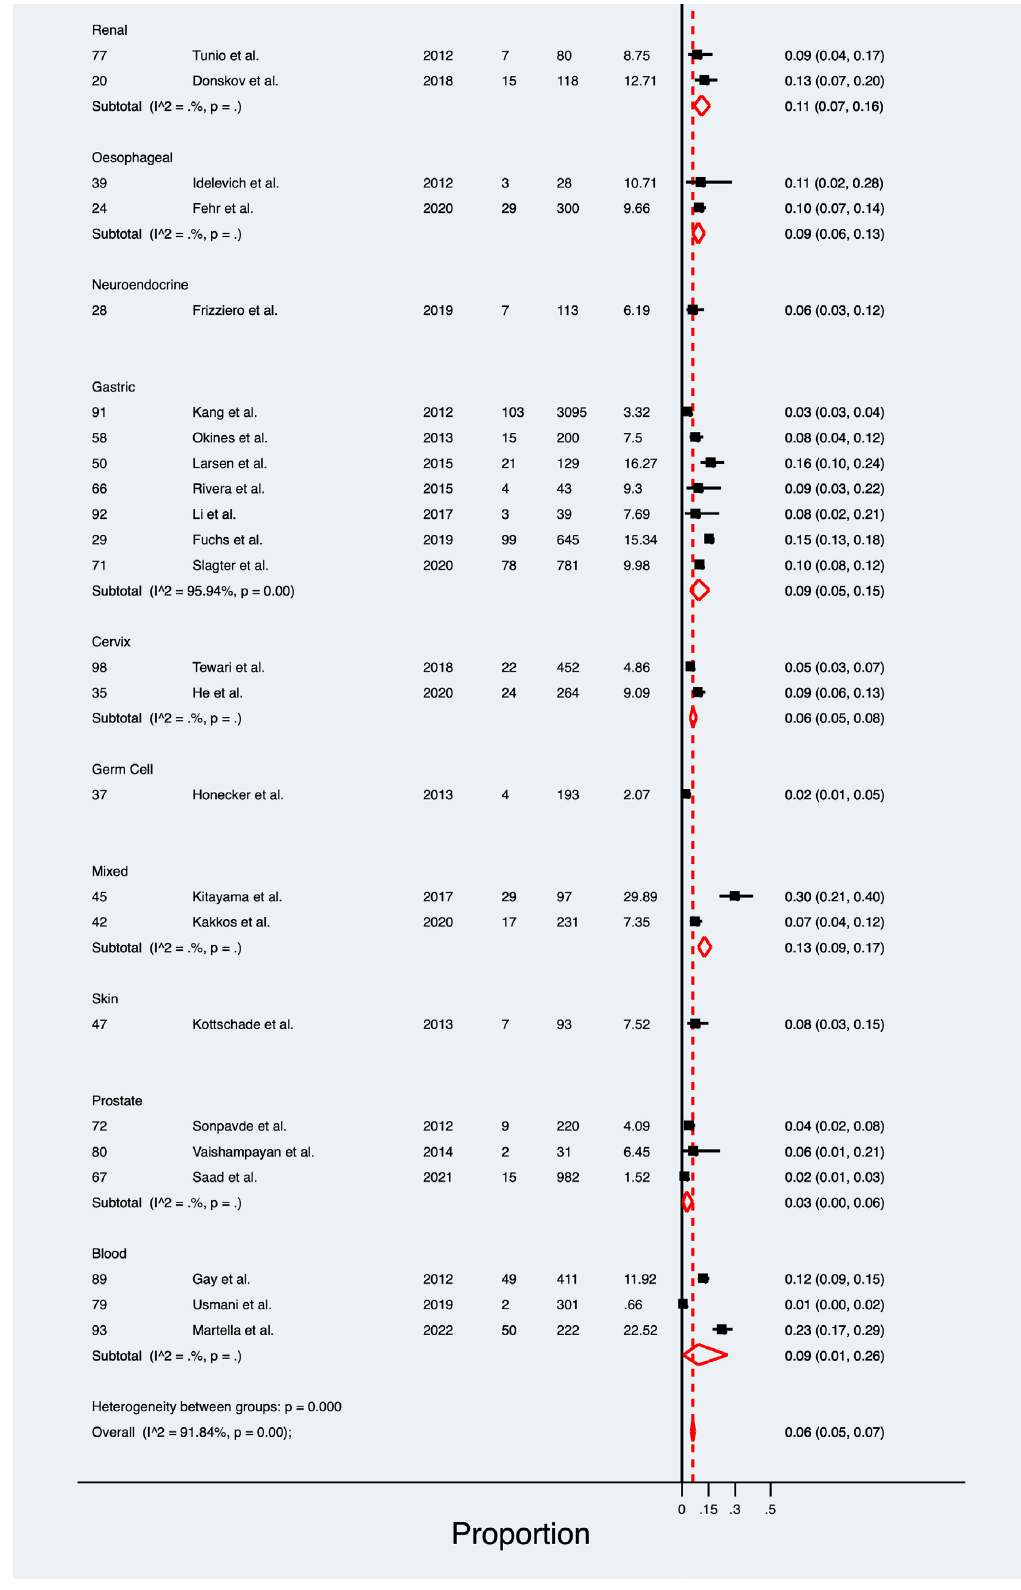
Figure 3. Forest plot showing the estimated pooled prevalence of VTE in cancer patients stratified by cancer phenotype [29–128]. Abbreviations: VTE: venous thromboembolism.